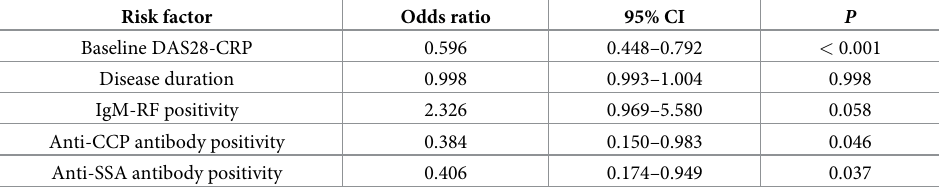
Table 5. Logistic regression analysis for rate of achieving low disease activity according to the DAS28-CRP, including baseline DAS28-CRP and disease